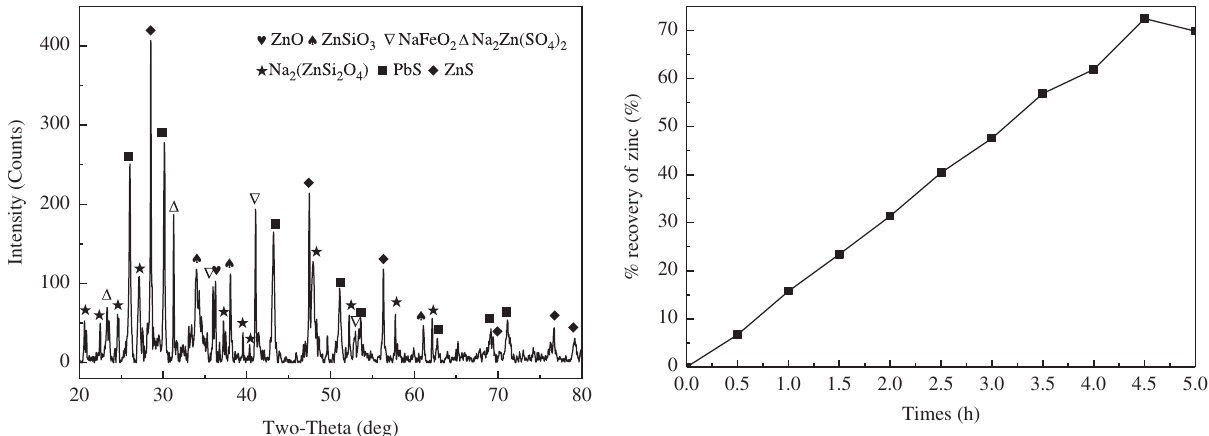
Figure 4: XRD of zinc sulfide ores after microwave heating pretreatment.